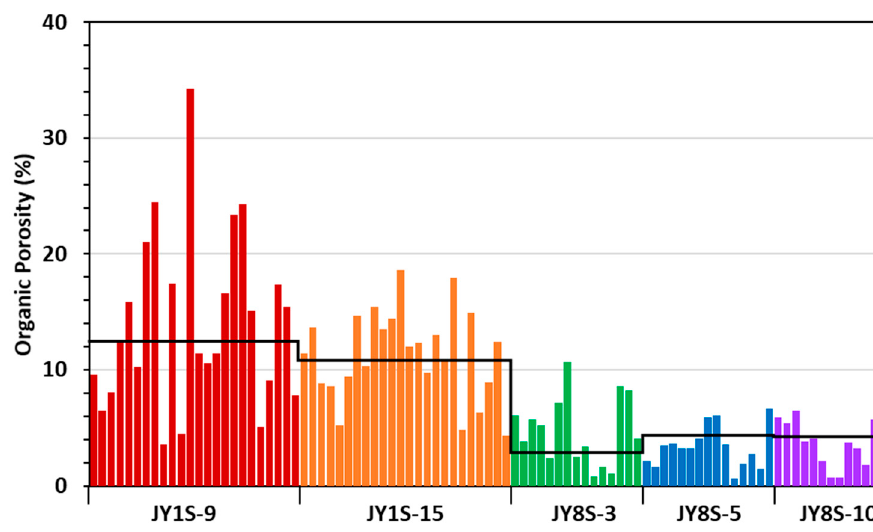
Figure 21. The organic porosity determined using SEM images of OMs and their average of five shale samples from Longmaxi-Wufeng Shale, Eastern Sichuan Basin. The black line indicates the average of organic porosity of the five shale samples; the histogram for an individual well has the same color.